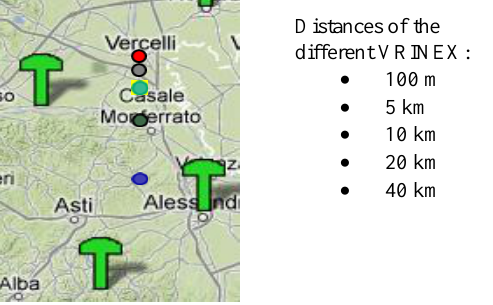
Figure 2. VRINEX with increasing distance from the CORS (Vercelli)